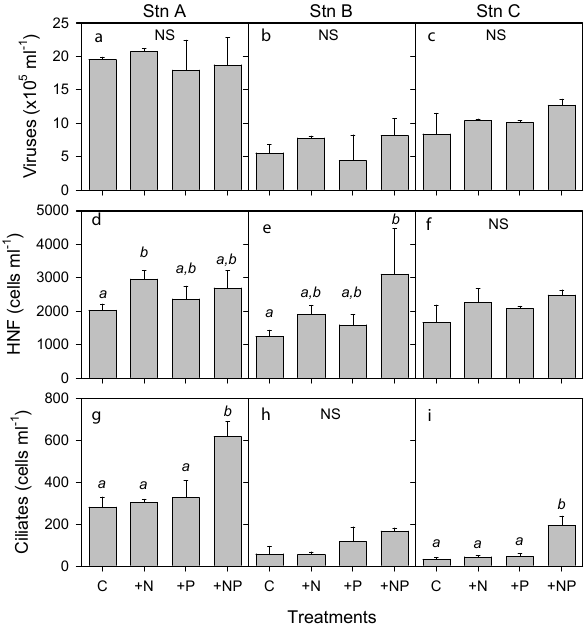
Fig. 6. Comparison of responses of abundance (particles or cellsml − 1 ) of viruses ( a, b, c ), heterotrophic nanoflagellates (HNF) ( d, e, f ), and ciliates ( g, h, i ) between the different treatments at the last day of the experiment except for viruses (data from Day 2). Values are shown as mean ± SD. C, +N, +P, and +NP denote Con- trol, NH 4 addition, PO 4 addition, NH 4 +PO 4 addition, respectively. Columns labeled by different italic letters ( a , b or c) are signifi- cantly different at P < 0 . 05. NS denotes no significant effect of different nutrient treatments on the parameter measured. See Mate- rials and methods for